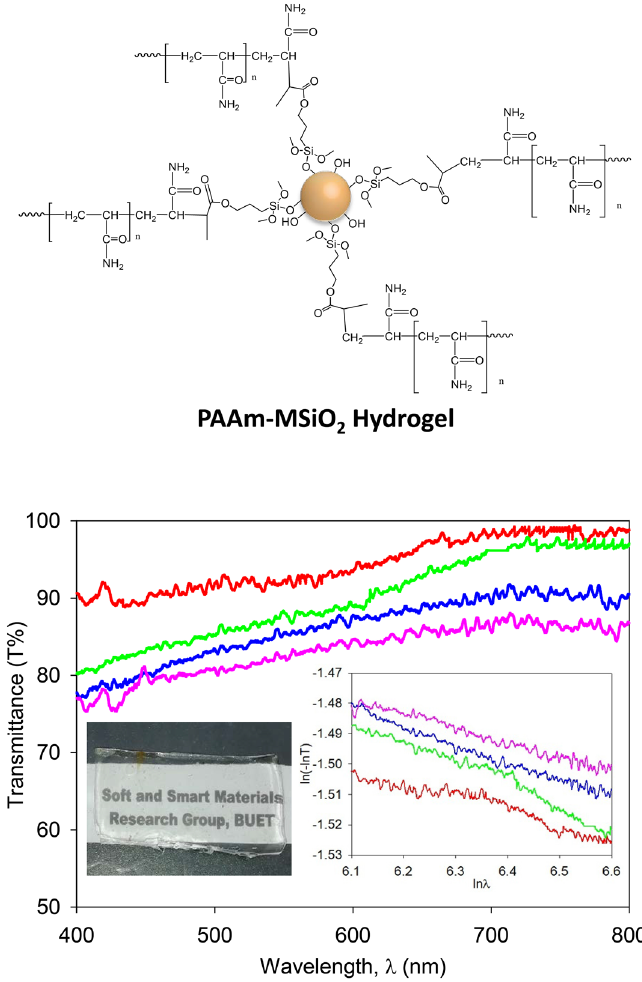
Figure 4. Proposed structure of PAAm-MSiO 2 hydrogel (top), the transmittance spectra of highly transparent hydrogel (bottom), transparent gel sample (inset-left), and the plots of ln(-lnT) versus lnλ (inset-right). In the graph, red line, green line, blue line, and purple line represent PAAm (4 M)-MSiO 2 0.50%, PAAm (4 M)-MSiO 2 0.75%, PAAm (4